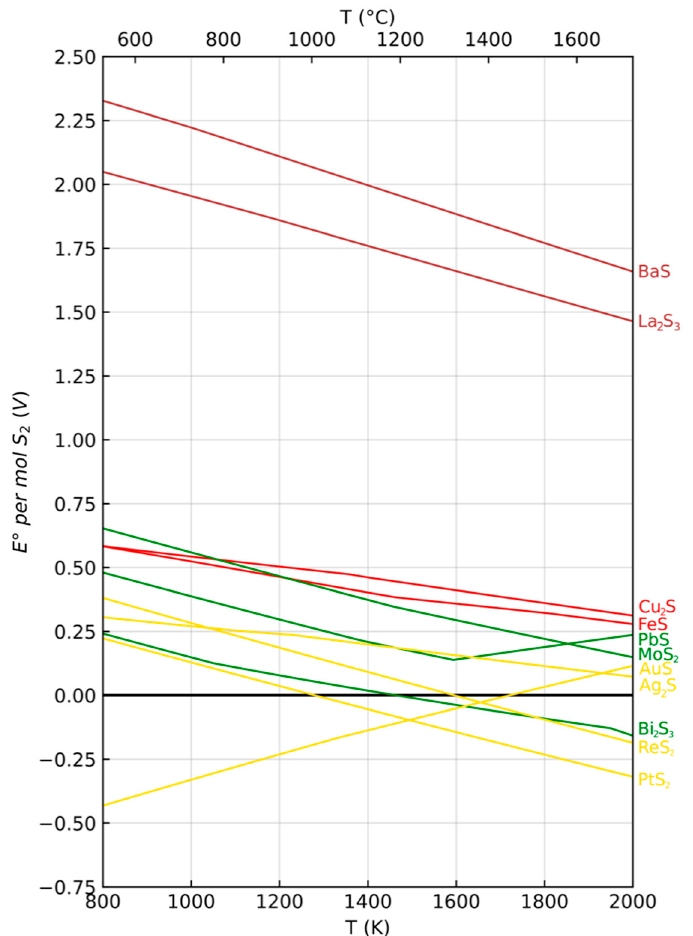
Figure 2. Sulfide Ellingham diagram with standard state decomposition voltage.